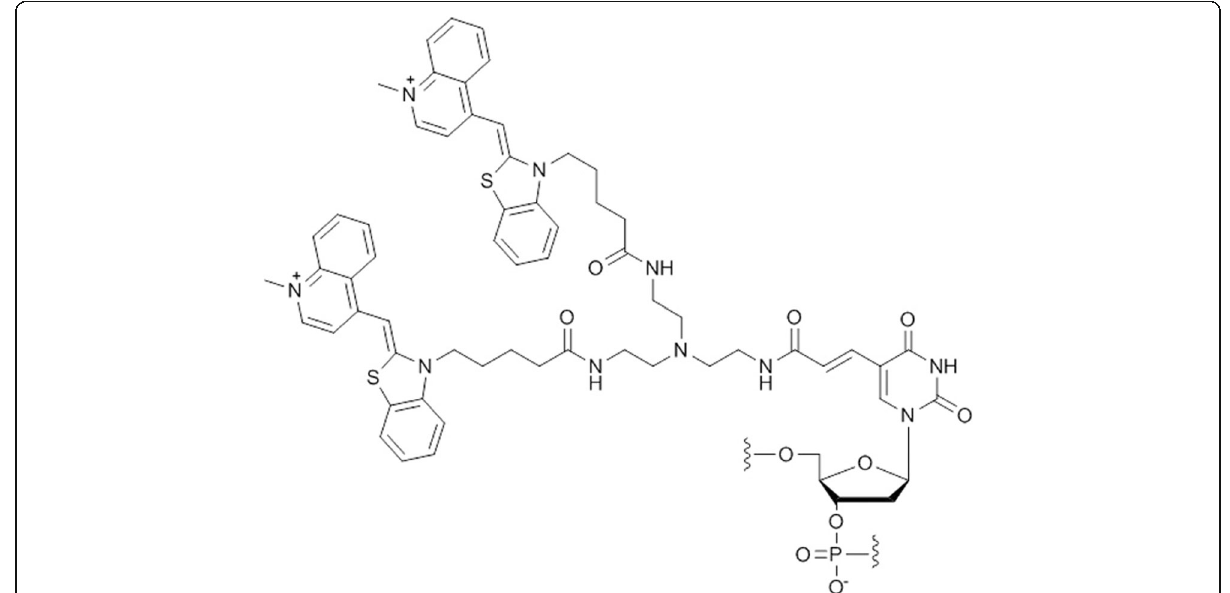
Fig. 1 Doubly TO-labeled nucleotide “ D 514 ” in ECHO